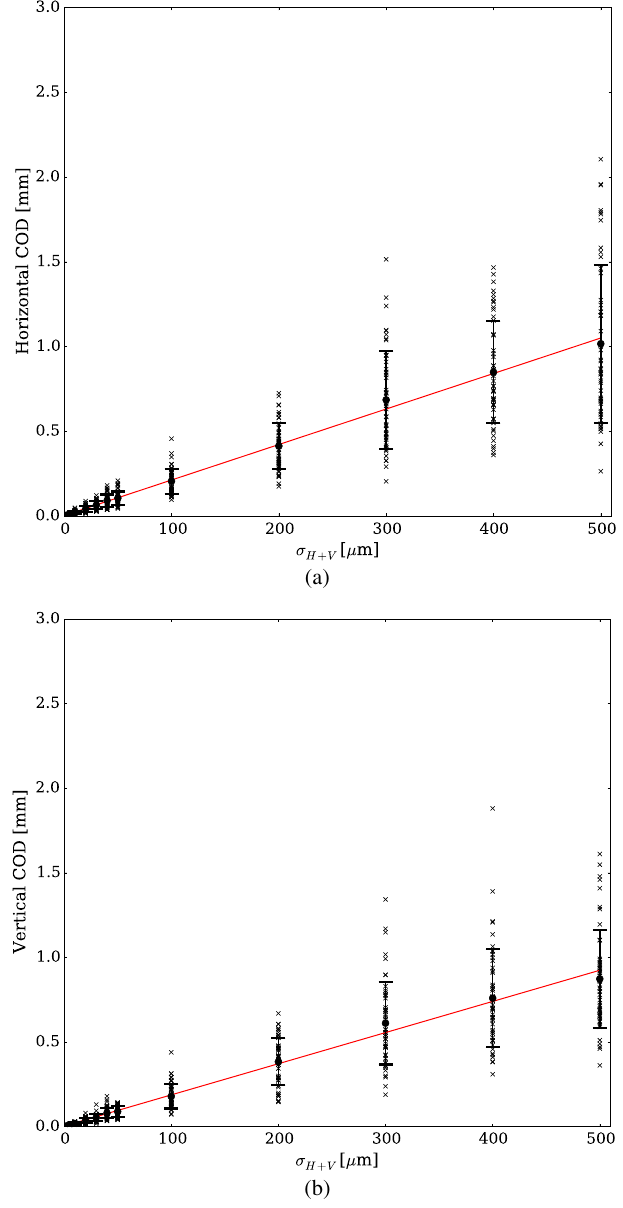
FIG. 18. The horizontal (a) and vertical (b) COD with cell misalignment errors for the racetrack lattice. Each individual randomly offset lattice is shown as a cross, the mean is shown as a filled circle, and the standard deviation as the error bars. The red line shows a minimum chi-squared fit to the data.